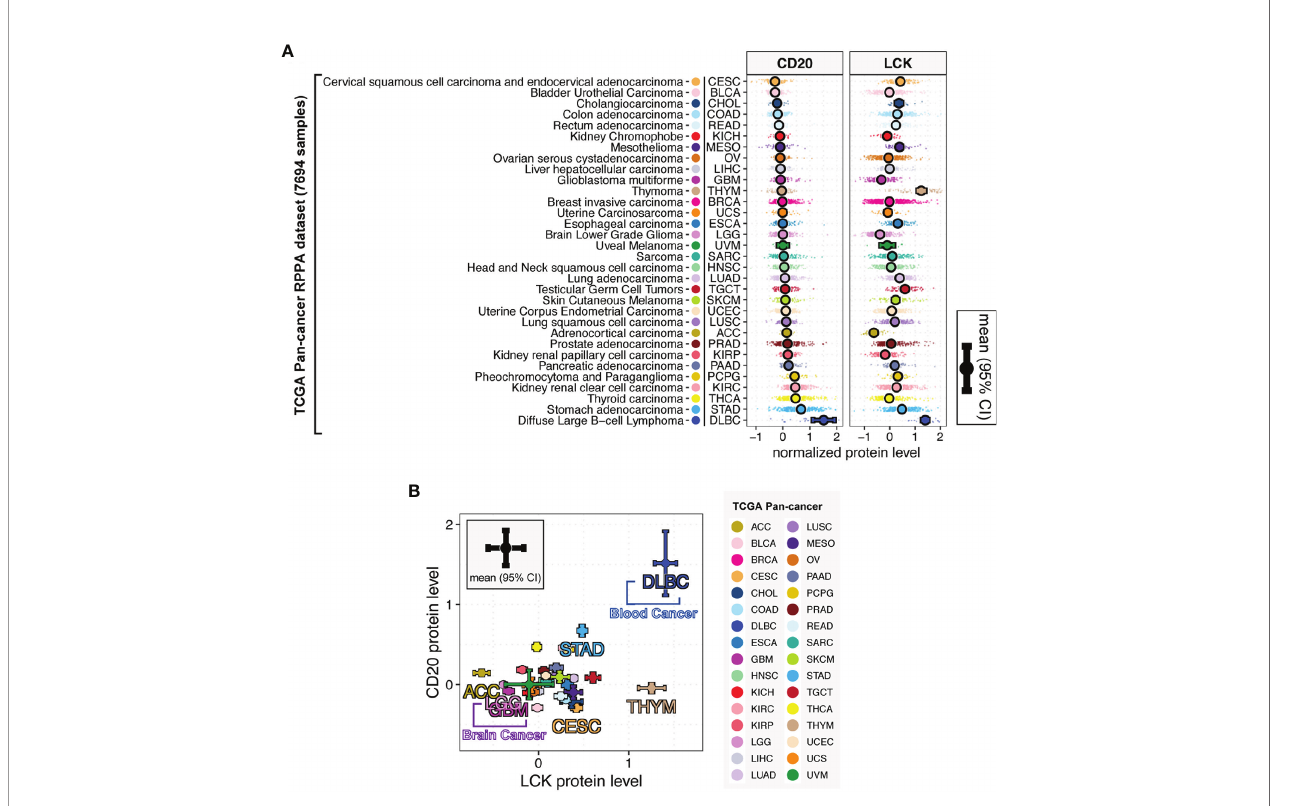
FIGURE 3 | LCK and CD20 protein levels across different cancer types. (A) The protein levels of CD20 and LCK across different cancer types. (B) The relationship between the CD20 and LCK protein levels. The error bar represents the 95% con fi dence interval (CI), the dot represents the average value, with color coding according to cancer